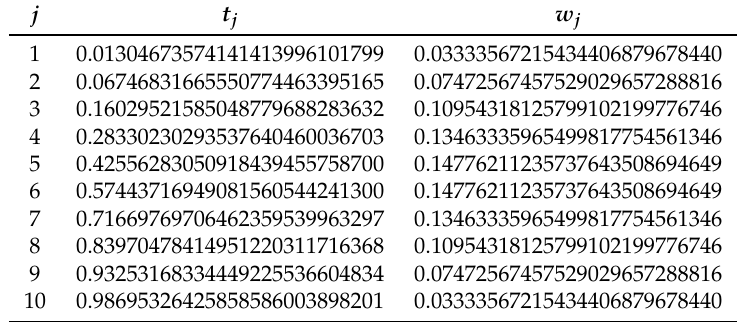
Table 9. Values of abscissas t j and weights w j